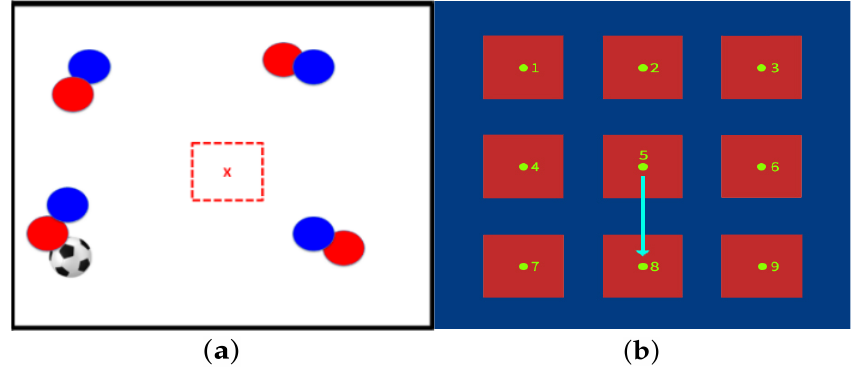
Figure 4. Example of soccer tactical situation and the expected response. ( a ) Offensive tactical situation, go to an uncovered pass position. ( b ) Response is running to target 8 on the platform.